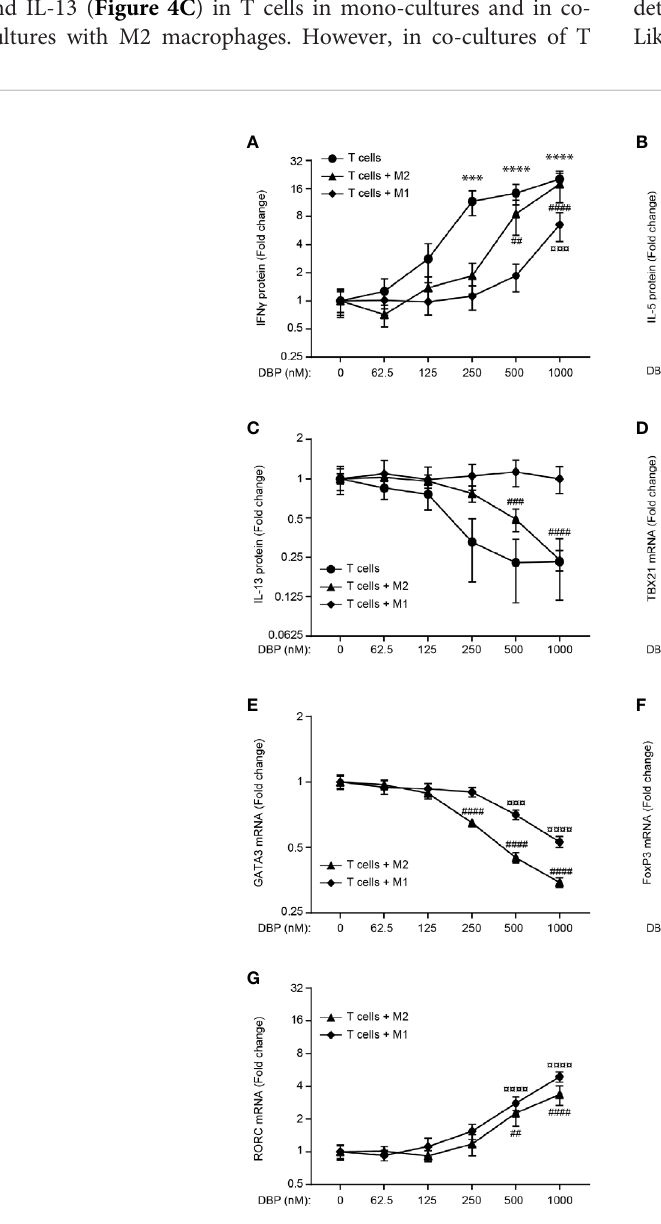
FIGURE 4 | Co-cultures of M1 macrophages and T cells produce suf fi cient 1,25(OH) 2 D 3 to affect T cell effector function in the presence of high concentrations of DBP. Relative (A) IFN- g , (B) IL-5 and (C) IL-13 concentrations in the supernatant of CD4 + T cells activated in mono-cultures with Dynabeads Human T-activator CD3/CD28 and CD4 + T cells co-cultured with allogeneic M1 and M2 macrophages activated with LPS and IFN g and LPS, respectively, for 96 hours in the presence of 100 nM 25(OH)D 3 and DBP at the indicated concentrations. Each series of data was normalized to the cytokine production in the presence of 100 nM 25(OH)D 3 and absence of DBP. Relative expression of Tbx21 (D) , GATA3 (E) , FoxP3 (F) and RORC (G) in CD4 + T cells co-cultured with allogeneic M1 and M2 macrophages activated with LPS and IFN g and LPS, respectively, for 96 hours in the presence of 100 nM 25(OH)D 3 and DBP at the indicated concentrations. Data (mean ± SEM) were obtained from two to fi ve independent experiments with 6 donors (4 T cells donors, 8 donor pairs for T cells in co-culture with M1 macrophages (4 T cell donors and 2 M1 macrophage donors mixed to 8 combinations) and 6 donor pairs for T cells in co-culture with M2 macrophages (3 T cell donors and 2 M2 macrophage donors mixed to 6 combinations). The data sets were tested using a one-way ANOVA with post hoc multiple comparisons test (Dunnett ’ s) to the cell cultures without DBP. *T cells treated with DBP versus T cells without DBP; # T cells + M2 macrophages treated with DBP versus T cells + M2 macrophages without DBP; ¤ T cells + M1 macrophages treated with DBP versus T cells + M1 macrophages without